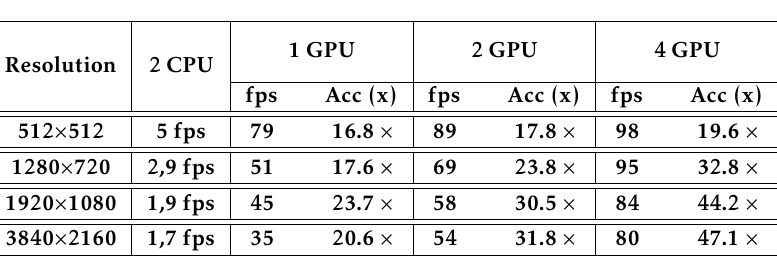
Table 1. GPU performances of motion detection using mobile